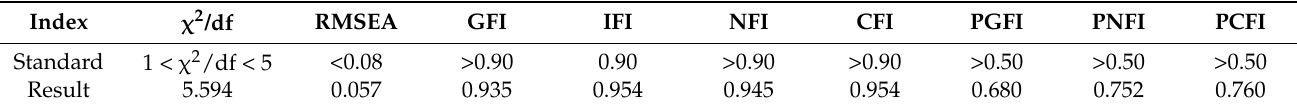
Table 5. Goodness-of-fit